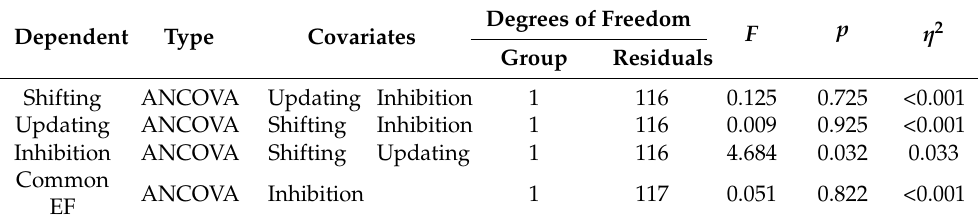
Table 4. Results of ANOVA and